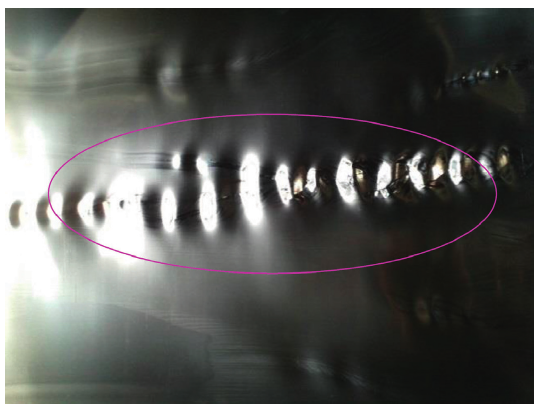
Figure 1: Photos of chatter mark on the strip